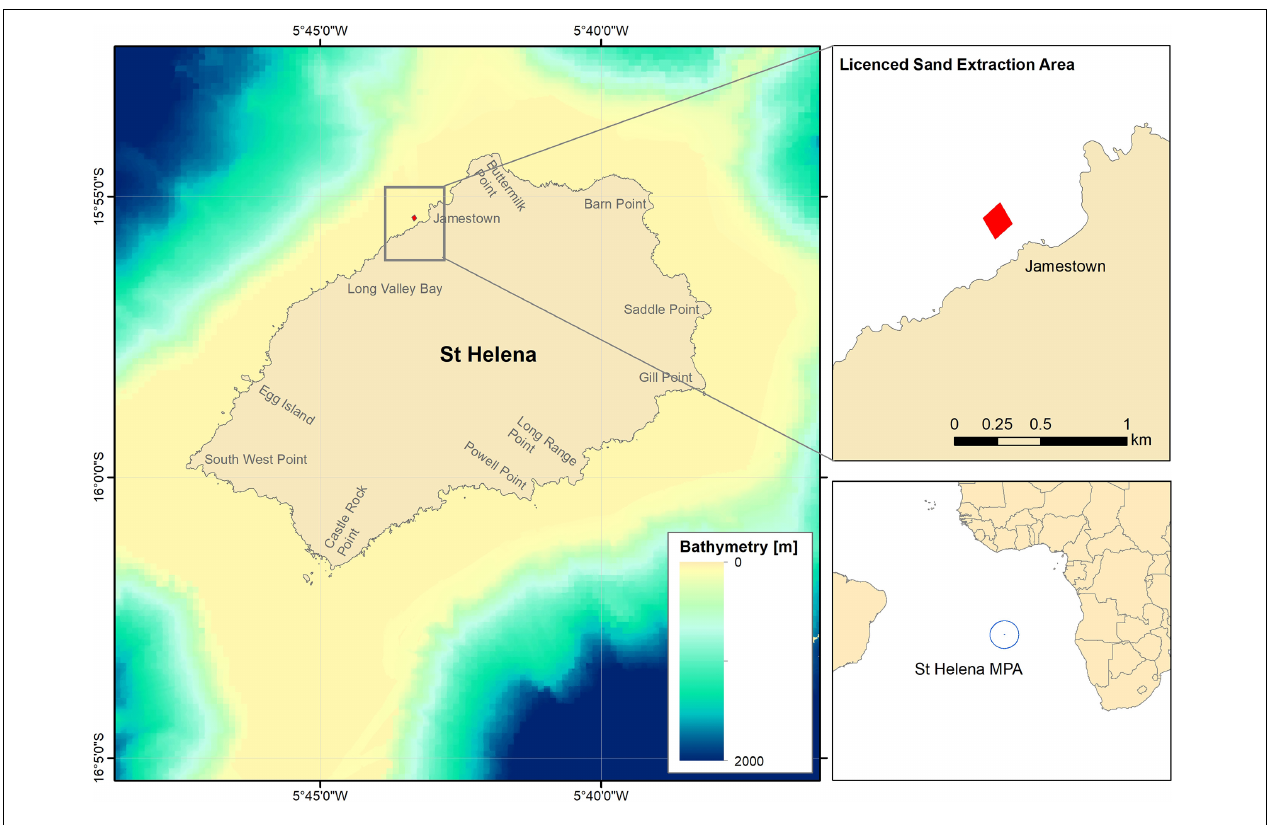
FIGURE 2 | Map of St Helena island (left insert) with a zoom into James Bay on the north coast of the island (upper right insert), where the majority of sand extraction activity takes place. St Helena is located in the mid-South Atlantic Ocean, and the entire 200 nm Exclusive Economic Zone is designated as an IUCN Category VI (Sustainable Use) MPA (lower right insert). Bathymetry data sources: Cefas, British Antarctic Survey and St Helena Government (2018 and